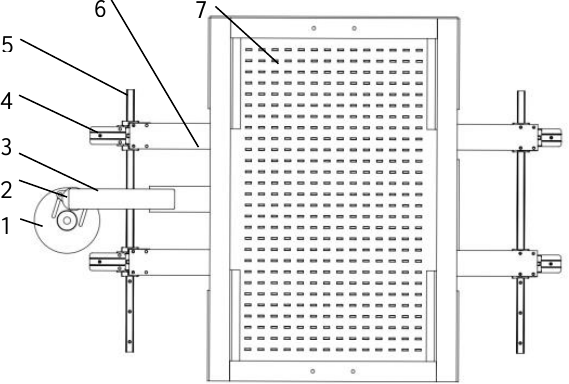
Figure 3. Structure of drive components. 1. Eccentric disc; 2. Bearing; 3. Connecting plate; 4. First slide rail; 5. Second slide rail; 6. Support plate; 7. Seed filling box.